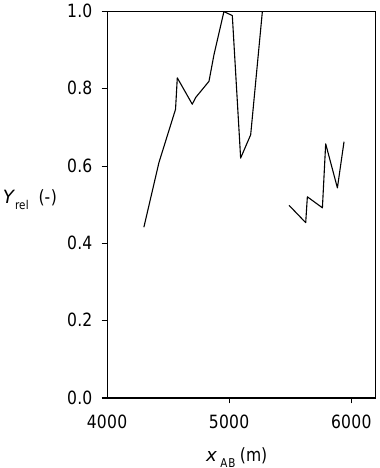
Fig. 13. Relative yield of potato along the cross-section AB (Fig. 5) Figure 13. Relative yield of potatoes along the cross section AB (Fig. 5), for the part that is in 2 for the part that is in use by agriculture and has the same podzolic use by agriculture and has the same podzolic soil type. 3 soil